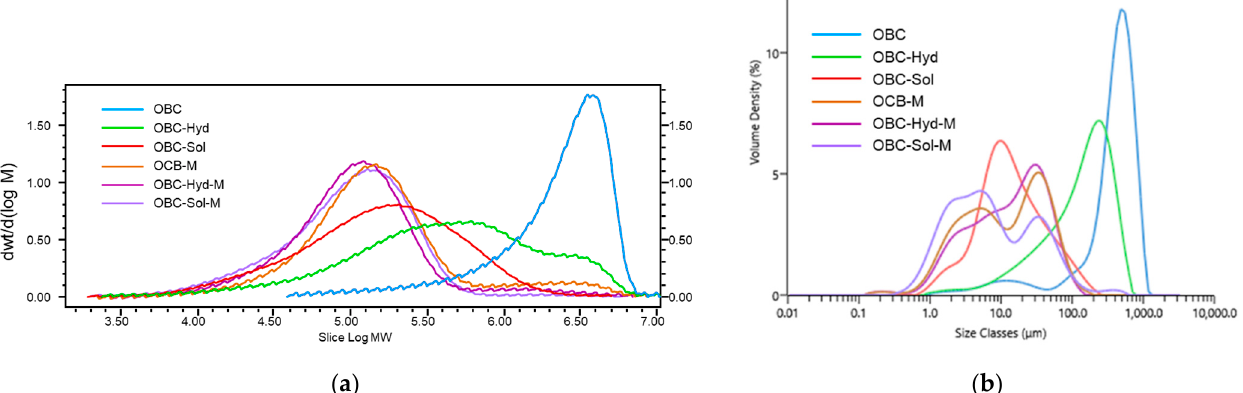
Figure 2. β -Glucan molecular weight distribution (Mw) (a ) and particle size distribution ( b ) of OBC samples of OBC samples. OBC: Oat bran concentrate; OBC-Hyd: OBC hydrolyzed with β -glucanase; OBC-Sol: water-soluble fraction from OBC after hydrolysis with β -glucanase; OBC-M: OBC microfluidized; OBC-Hyd-M: OBC-Hyd microfluidized; OBC-Sol-M: OBC-Sol microfluidized. A positive correlation was found between the β -glucan Mw and the average particle Table 1. Characteristics of OBC samples: β -glucan content, average particle size, WRC, extractability size (d 50 ) of OBC samples (r =0.99**). The OBC had an average particle size (d 50 ) of 426 μ m and properties in